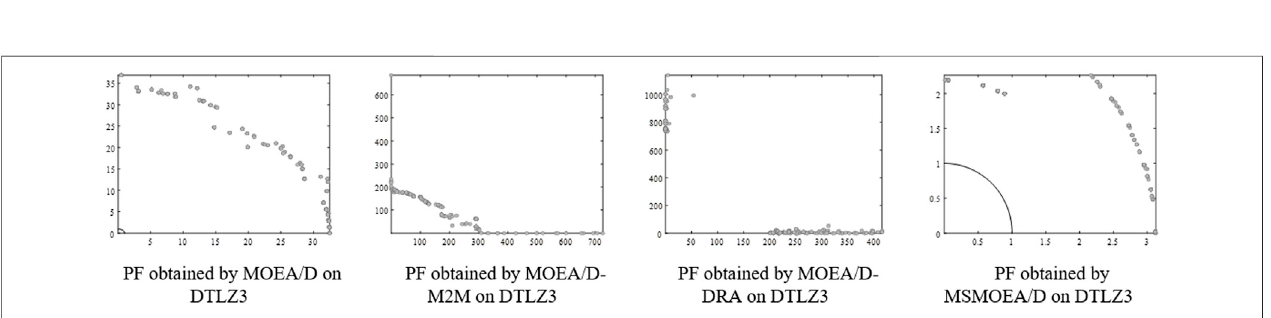
FIGURE 6 | PF obtained by MSMOEA/D and MOEAs on two-objective DTLZ3.